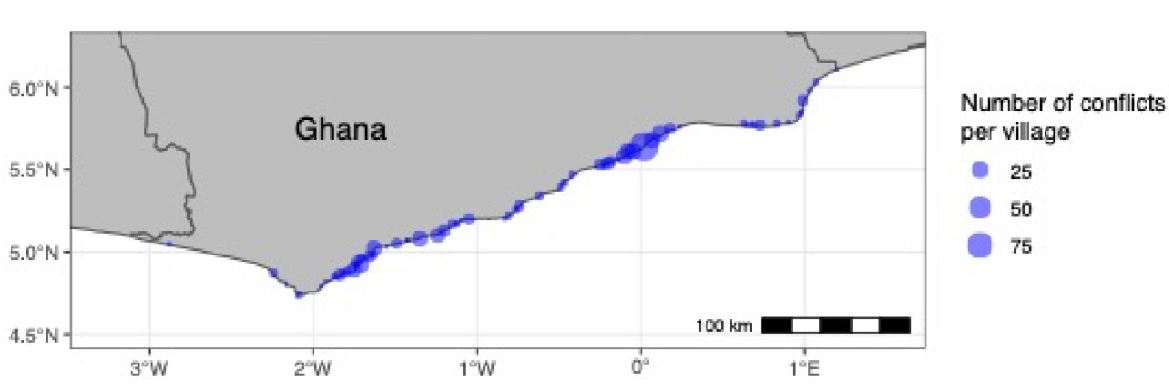
Fig. A1.1 : Map of associated Ghanaian villages in whose waters conflicts occurred. The size of the point is indicative of the number of cases that were submitted for conflicts in those villages' waters. The map includes the n=380 conflicts included in this analysis.